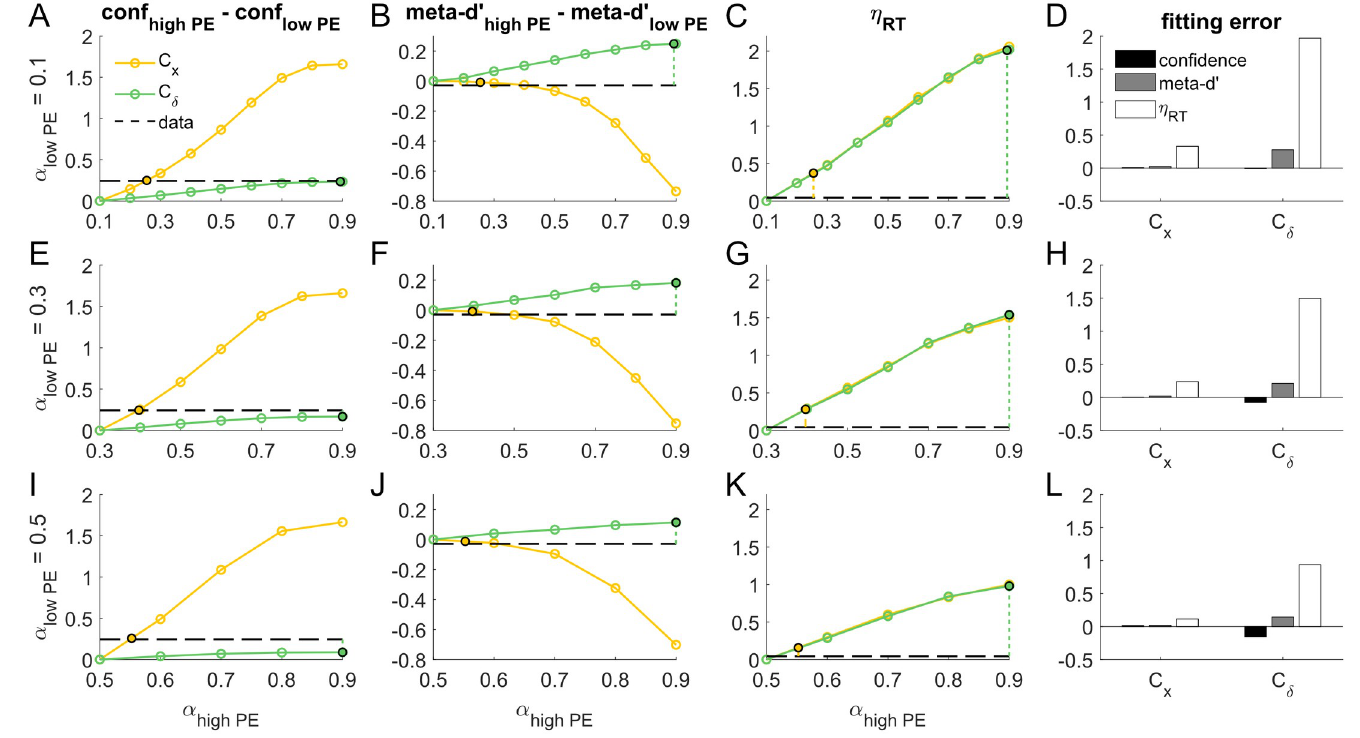
Fig 3. Comprehensive simulations showing fitting procedures for the main C x model and alternative C δ model for Koizumi et al.’s [10] Experiment 1A. Rows show simulation results for different settings of α low PE , which determines the relative strength of positive evidence (PE) and negative evidence (NE) in simulations for the Low PE condition of Koizumi et al., such that S NE / S PE = α low PE . Columns show performance-matched confidence differences (i.e. differences in confidence when d’ is exactly matched at the mean d’ value of the low PE condition), performance-matched meta-d’ differences, relative RT effect sizes ( η RT ), and model fitting error due to PE manipulations for Koizumi et al.’s Experiment 1A. For each of the C x and C δ models and each PE/NE balance in the Low PE condition ( α low PE ), we determined the level of NE in the High PE condition ( α high PE ) that best matched the observed magnitude of performance-matched confidence differences in the empirical data (dashed horizontal lines, column 1); these are marked with black circles. We then “read out” the predicted meta-d’ differences and relative RT effect sizes (columns 2 and 3, respectively) for each of these best-fitting PE/NE levels to get a comprehensive picture of the behavior of the system for both the C x and C δ models. Fitting error was computed for each model simply as the difference between the predicted value and the empirical value for confidence differences, meta-d’ differences, and relative RT effect sizes (column 4). Across all PE/NE balance levels tested, the C x model produced comprehensively good fit to the empirical data from Koizumi et al.’s Experiment 1A; in contrast, the alternative C δ model must be pushed to extremely high levels of α high PE to capture the empirically observed confidence differences due to PE manipulations, leading to substantial errors in the corresponding fits for meta-d’ and